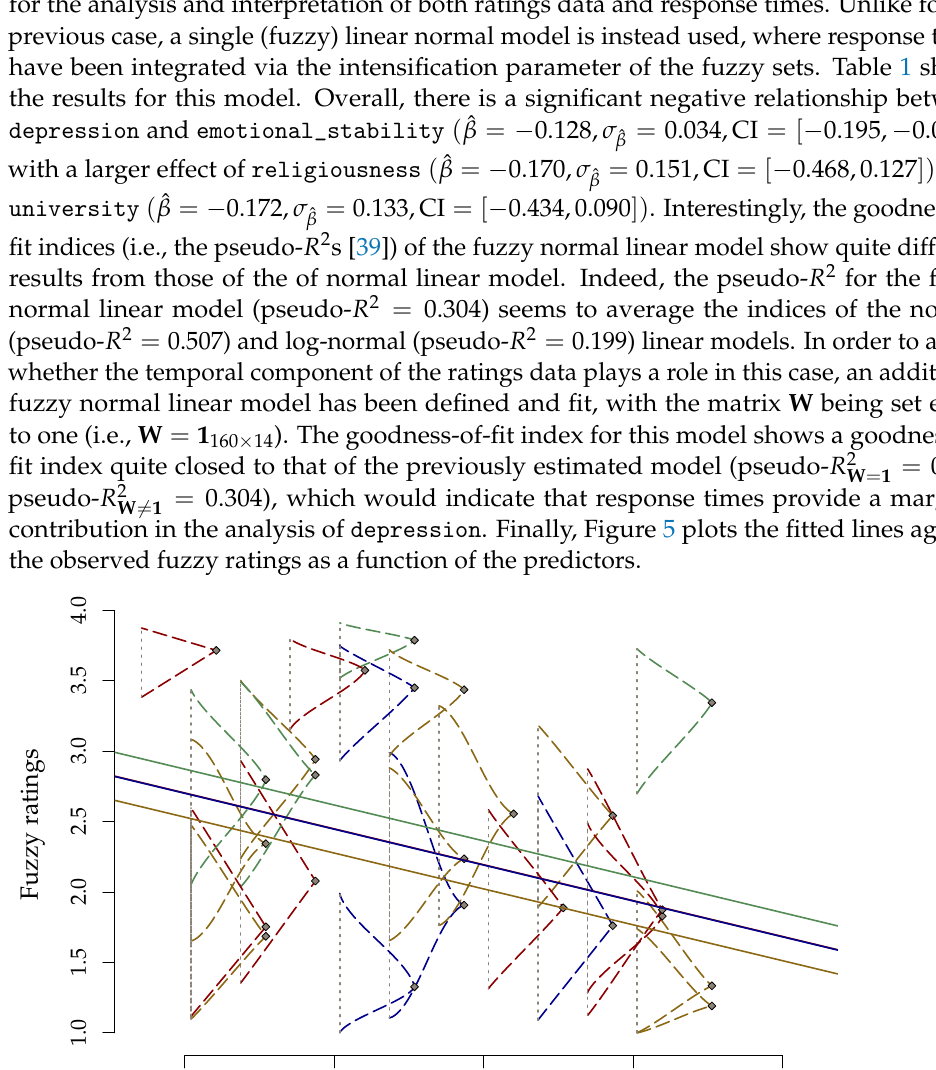
∧ university:yes ∧ ∧ university:yes ). ∧